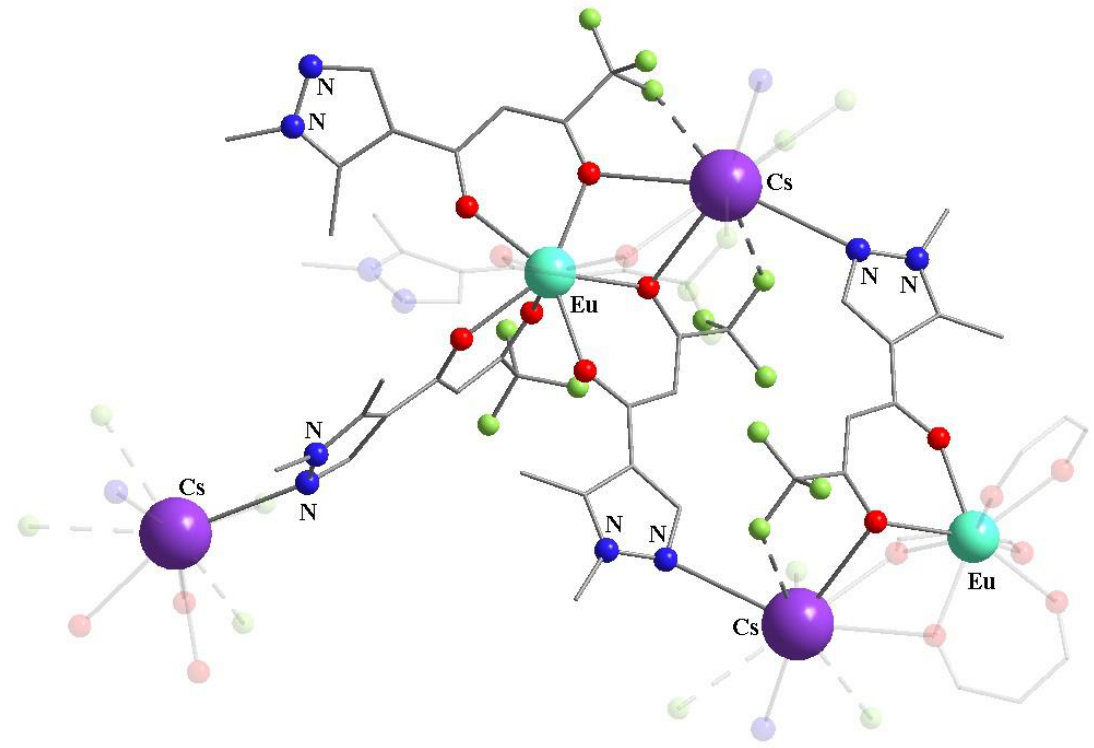
Figure 14. Structure X-ray structure of one-dimensional chain in 31 [82]. Hydrogen atoms have been omitted, some diketonate ligands and CF 3 groups are transparent for clarity. The cif has been retrieved from CCDC. CCDC number is 922987.